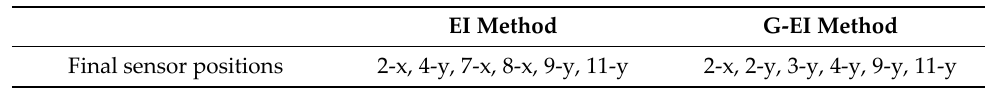
Table 1. Final sensor positions.